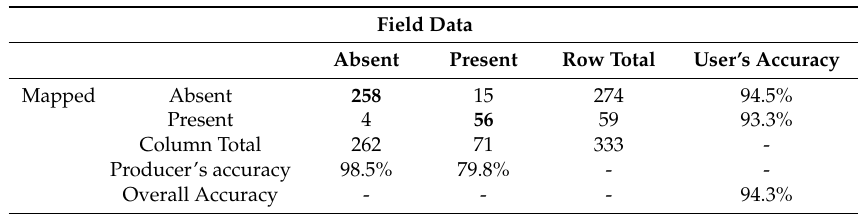
Table 5. Model accuracy of integrated RT classification trained with visual interpretation of the landscape (larger training set than the logistic